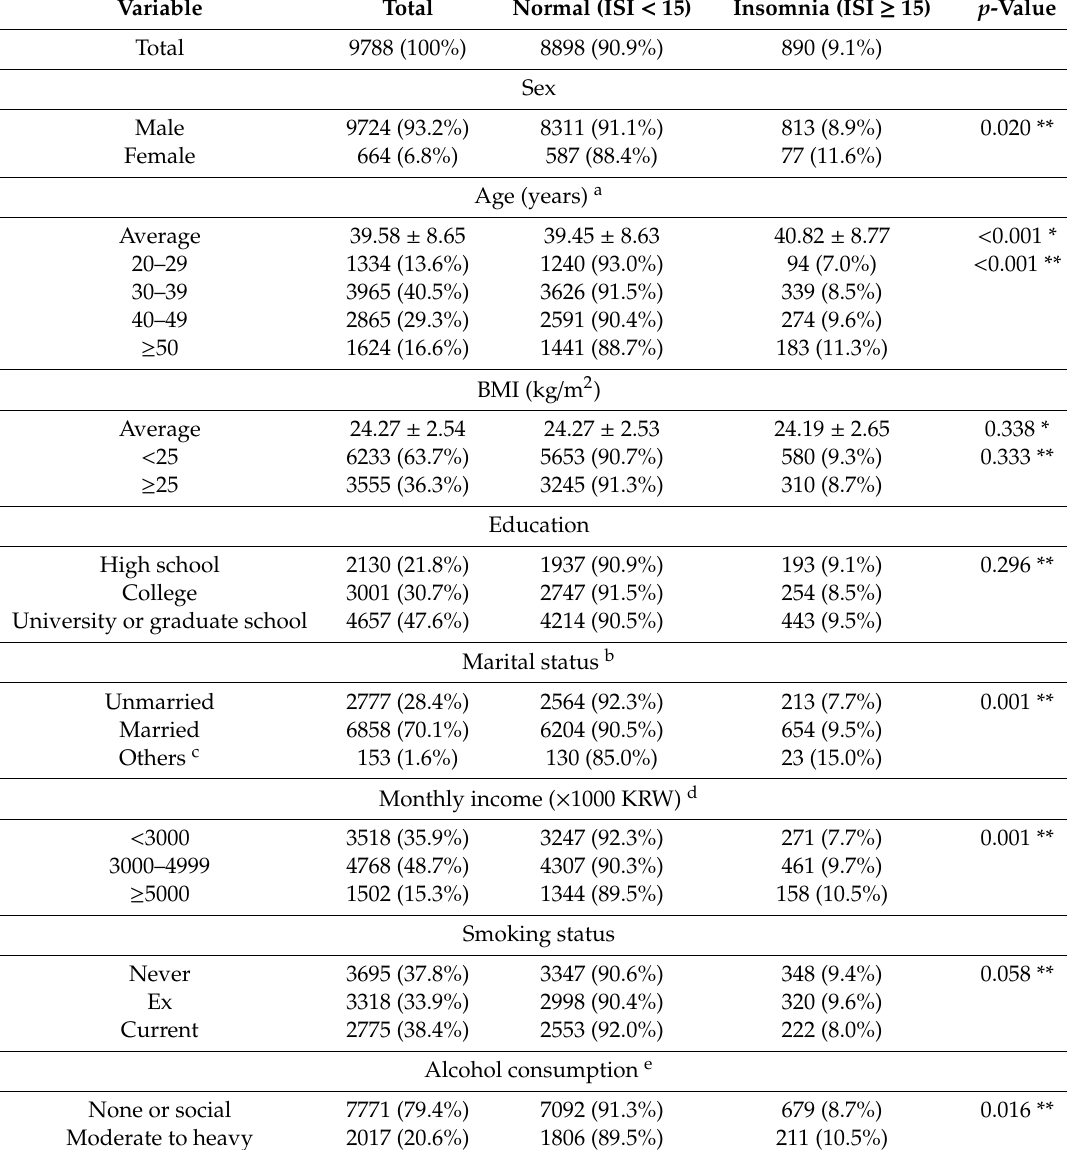
Table 1. Sociodemographic, organizational, and psychological characteristics of the study